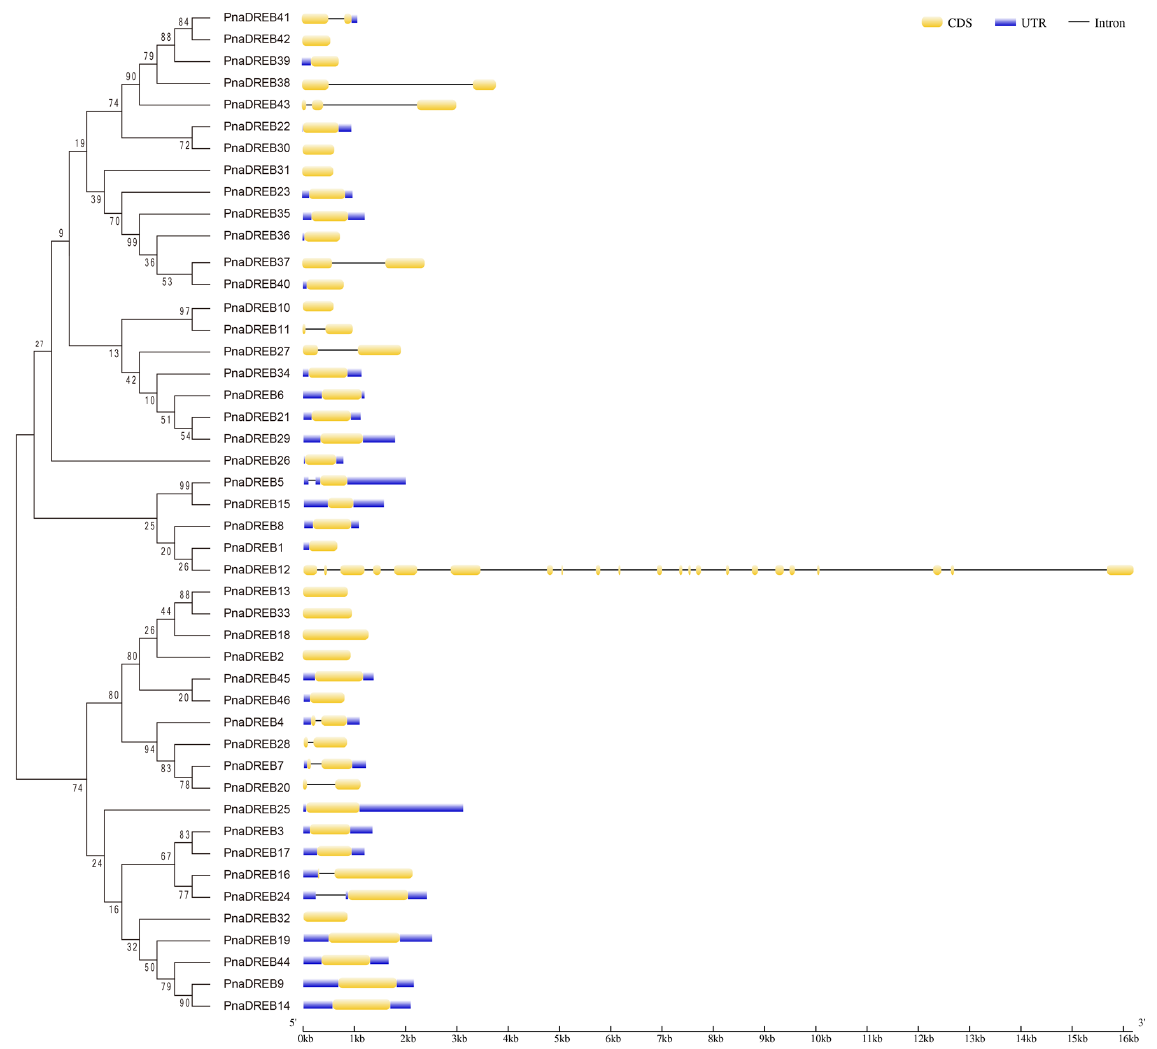
Figure 3. PnaDREB gene structure analyses. Exons, introns, and 5 ′ /3 ′ -untranslated regions are represented by the yellow box, black line, and pink box, respectively.